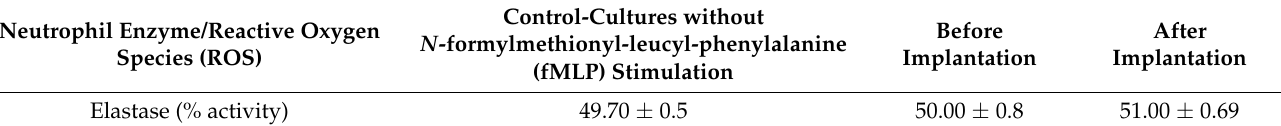
Table 1. Activity of rabbit neutrophils isolated before and after osteochondral transplantation (OT) assessed on the basis of enzyme release and free radical generation. Control-Cultures without Neutrophil Enzyme/Reactive Oxygen Before After N -formylmethionyl-leucyl-phenylalanine Species (ROS) Implantation Implantation (fMLP) Stimulation Elastase (% activity) 49.70 ± 0.5 51.00 ± 0.69 Myeloperoxidase (MPO % activity) 23.03 ± 0.5 Alkaline phosphatase (ALP % activity) Nitric oxide (NO µ M of